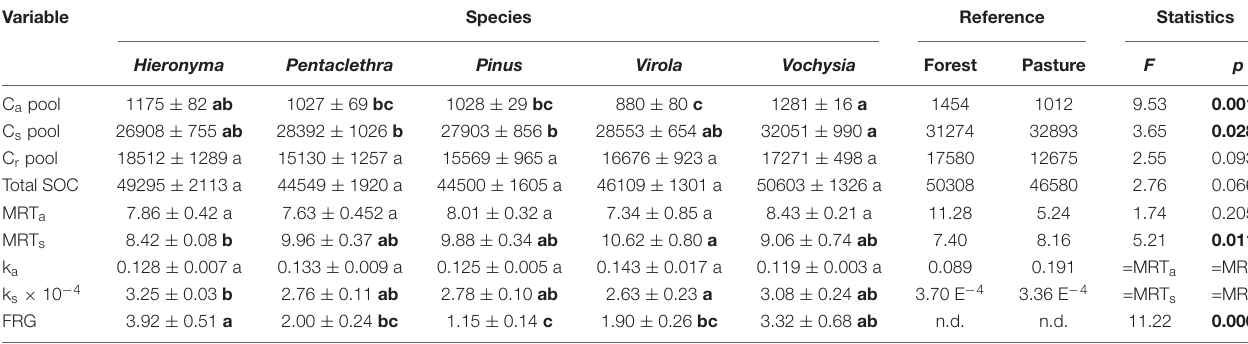
TABLE 3 | Soil organic carbon (SOC) pools and their turnover and fine-root growth (FRG) in five tropical tree species. Variable Species